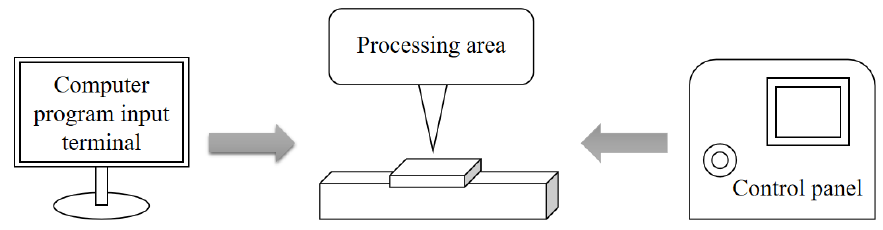
Figure 1. The preparation process.